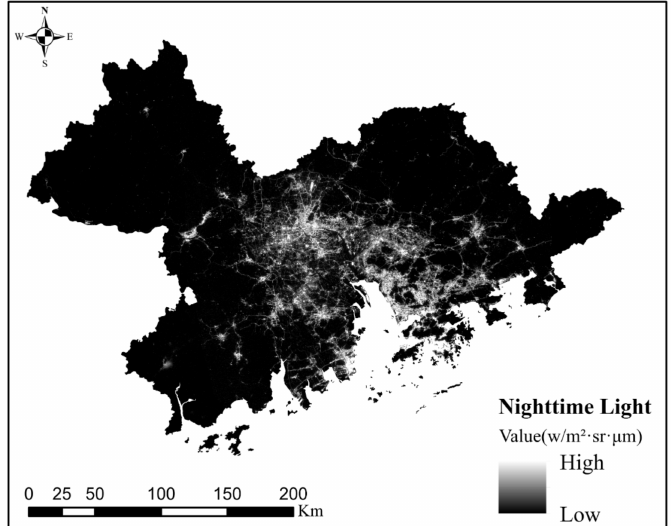
Figure 2. NTL data preprocessing of urban agglomerations in GBA.